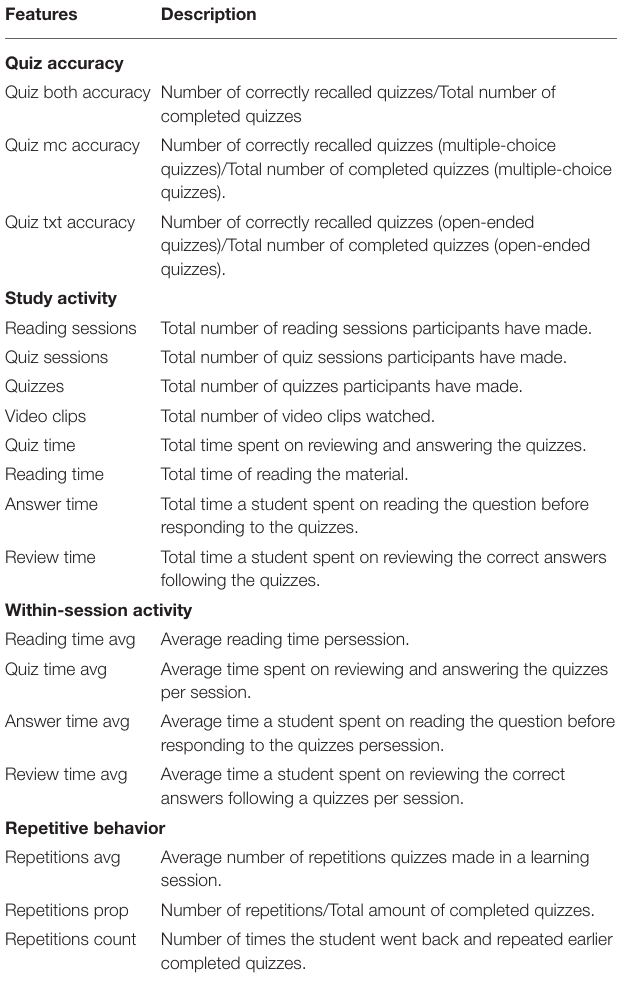
TABLE 1 | Features extracted of online